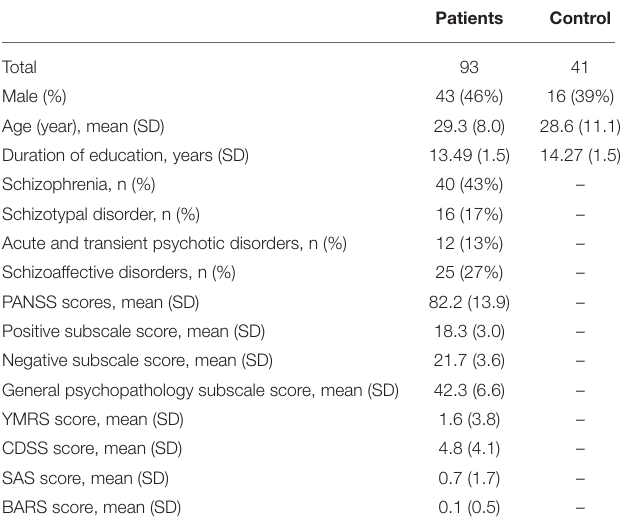
TABLE 1 | Demographic and disease characteristics of the study participants.